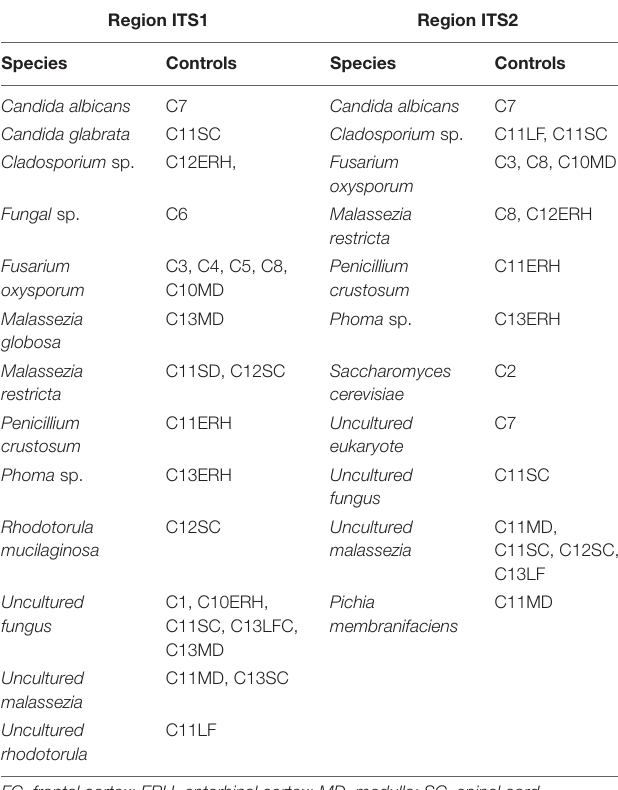
TABLE 2 | Fungal species detected in different brain regions of control subjects by PCR. Region ITS1 Region